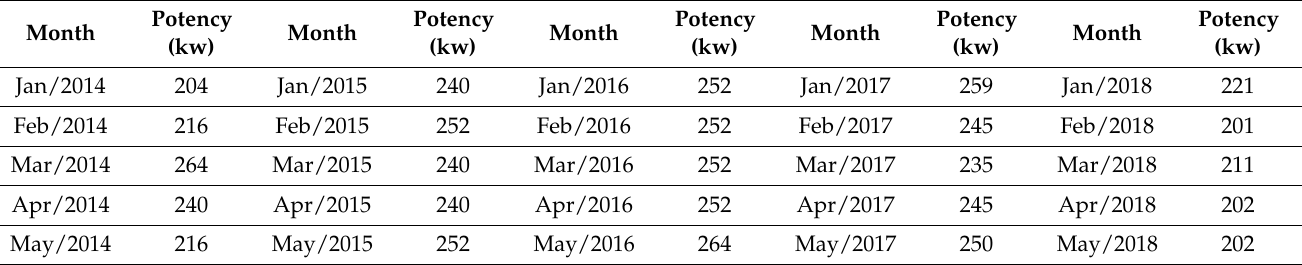
Table A1. Power demand consumption